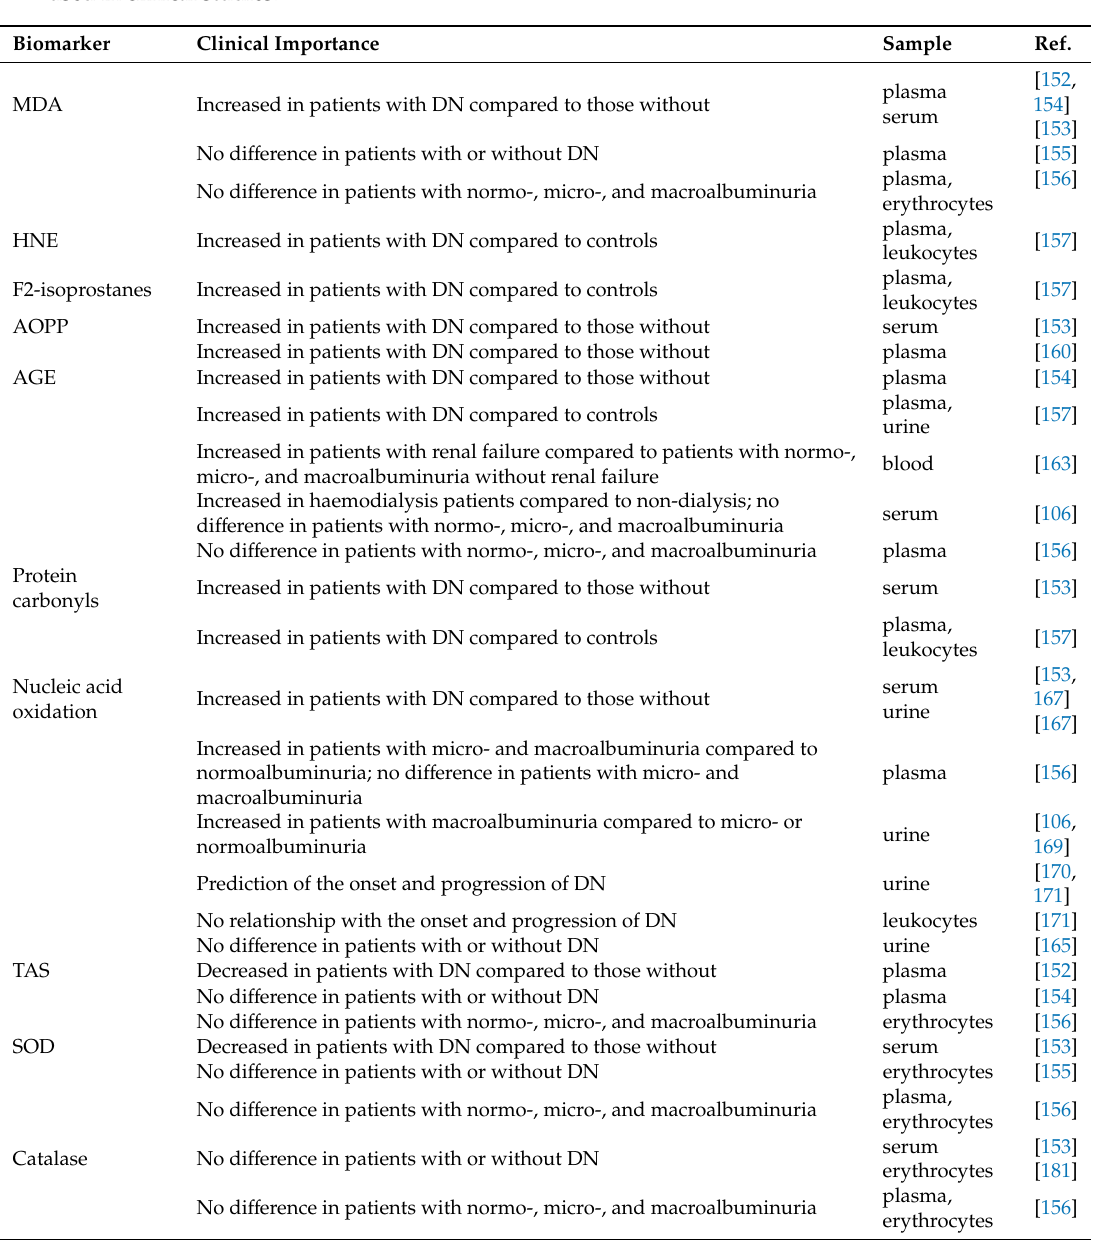
Table 2. Most important biomarkers of oxidative stress associated with diabetic nephropathy (DN) used in clinical